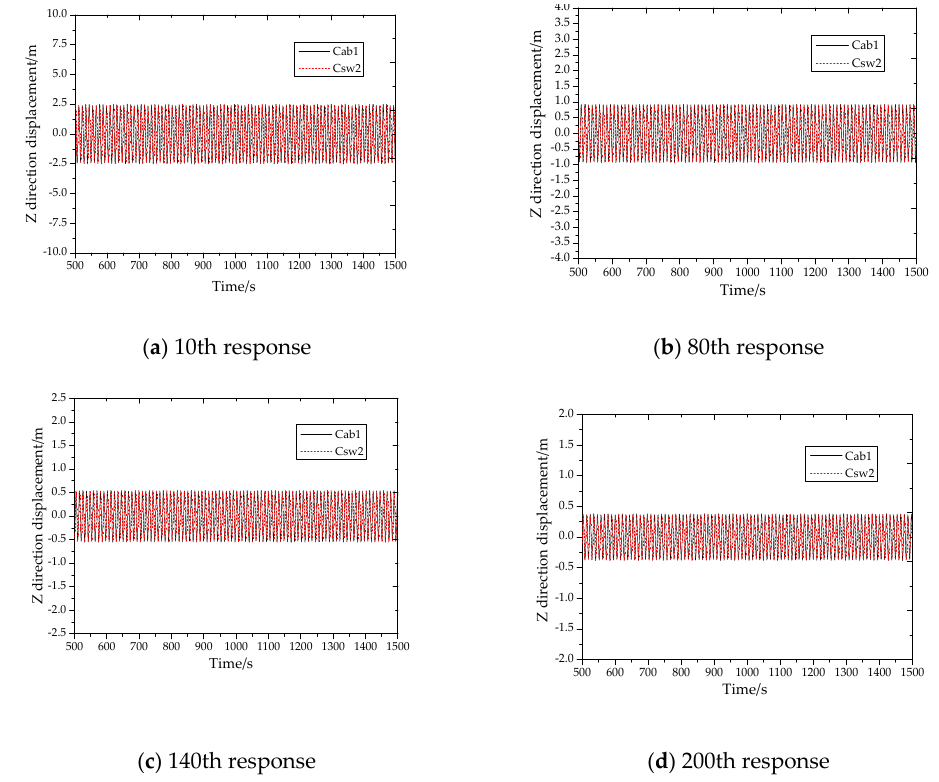
Figure 12. 10th-200th z -direction time history response in condition 1. Figure 12. 10th–200th z -direction time history response in condition